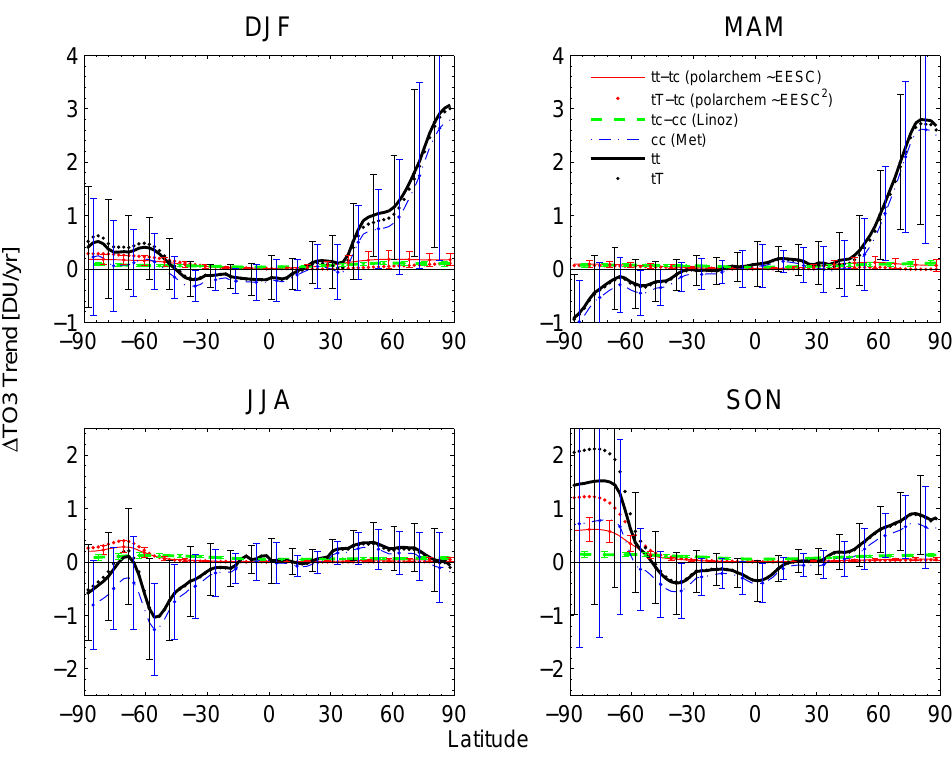
Fig. 12. Like Fig. 11, but for the 2000–2009 period. Attribution of TO3 trends to effects of ODS change on gas phase chemistry ( tc − cc ), ODS change on polar chemistry ( tt − tc and tT − tc , respectively), and natural variability under constant atmospheric composition ( cc ). Total trends are shown as a reference ( tt and tT